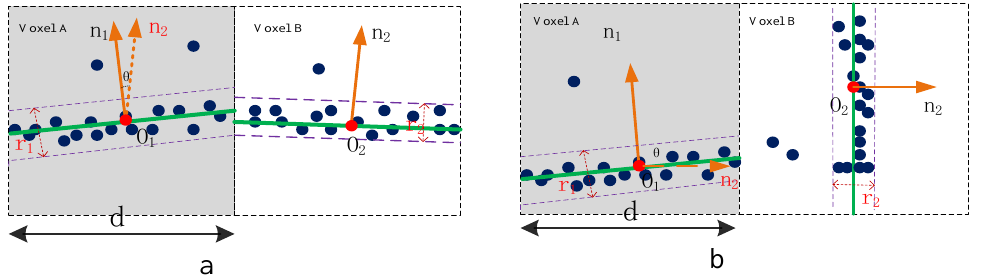
Figure 5. Voxel smoothness constraint. ( a ) Voxels A and B satisfy smoothness constraint θ AB ≤ θ th and ( b ) voxels A and B do not satisfy smoothness constraint θ AB > θ th . (2) Continuity constraint: To judge whether points in two adjacent voxels belong to the same plane,